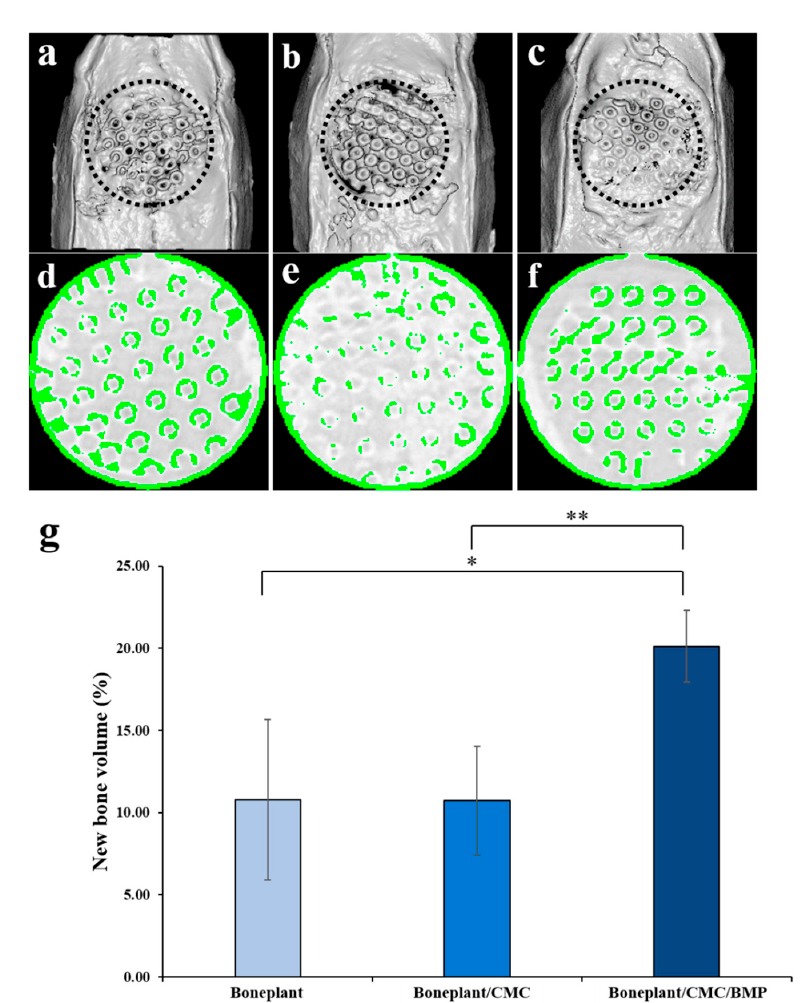
Figure 6. Micro-computed tomography ( µ CT) findings. ( a – f ) Obtained µ CT images of each group. ( a , d ) Boneplant; ( b , e ) Boneplant / CMC; ( c , f ) Boneplant / CMC / BMP groups. ( a – c ) 3D-reconstructed µ CT images. ( d – f ) colored µ CT images. Green colored area: newly formed bone. Gray colored area: grafted block bone. ( g ) New bone volume within region of interest. The symbol * indicates statistical significance ( P < 0.05). The symbol ** indicates statistical significance ( P < 0.01).